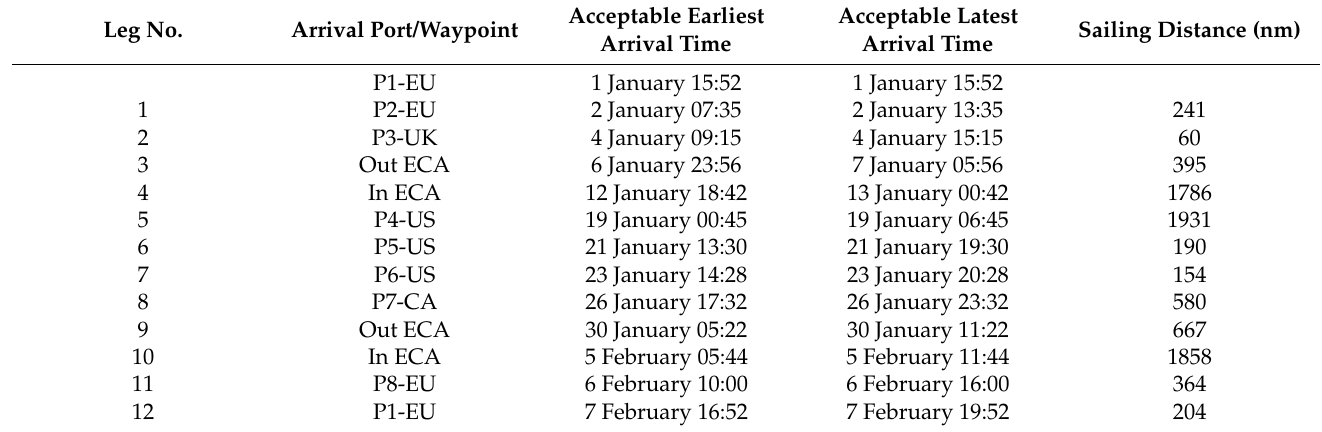
Table 3. Time windows and route in the considered example.